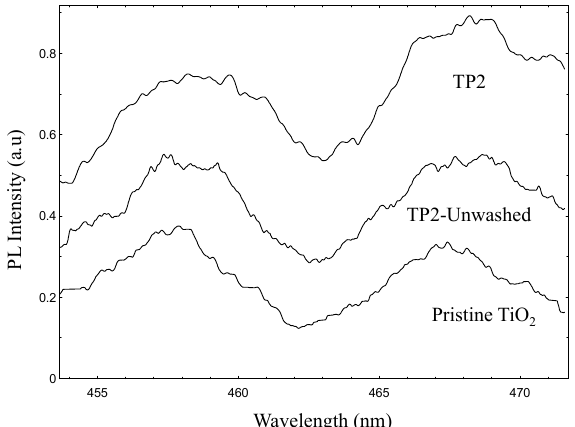
Figure 8. Photoluminescence spectra of pristine TiO 2 , unwashed TP2 and washed TP2 samples. PL, photoluminescence.